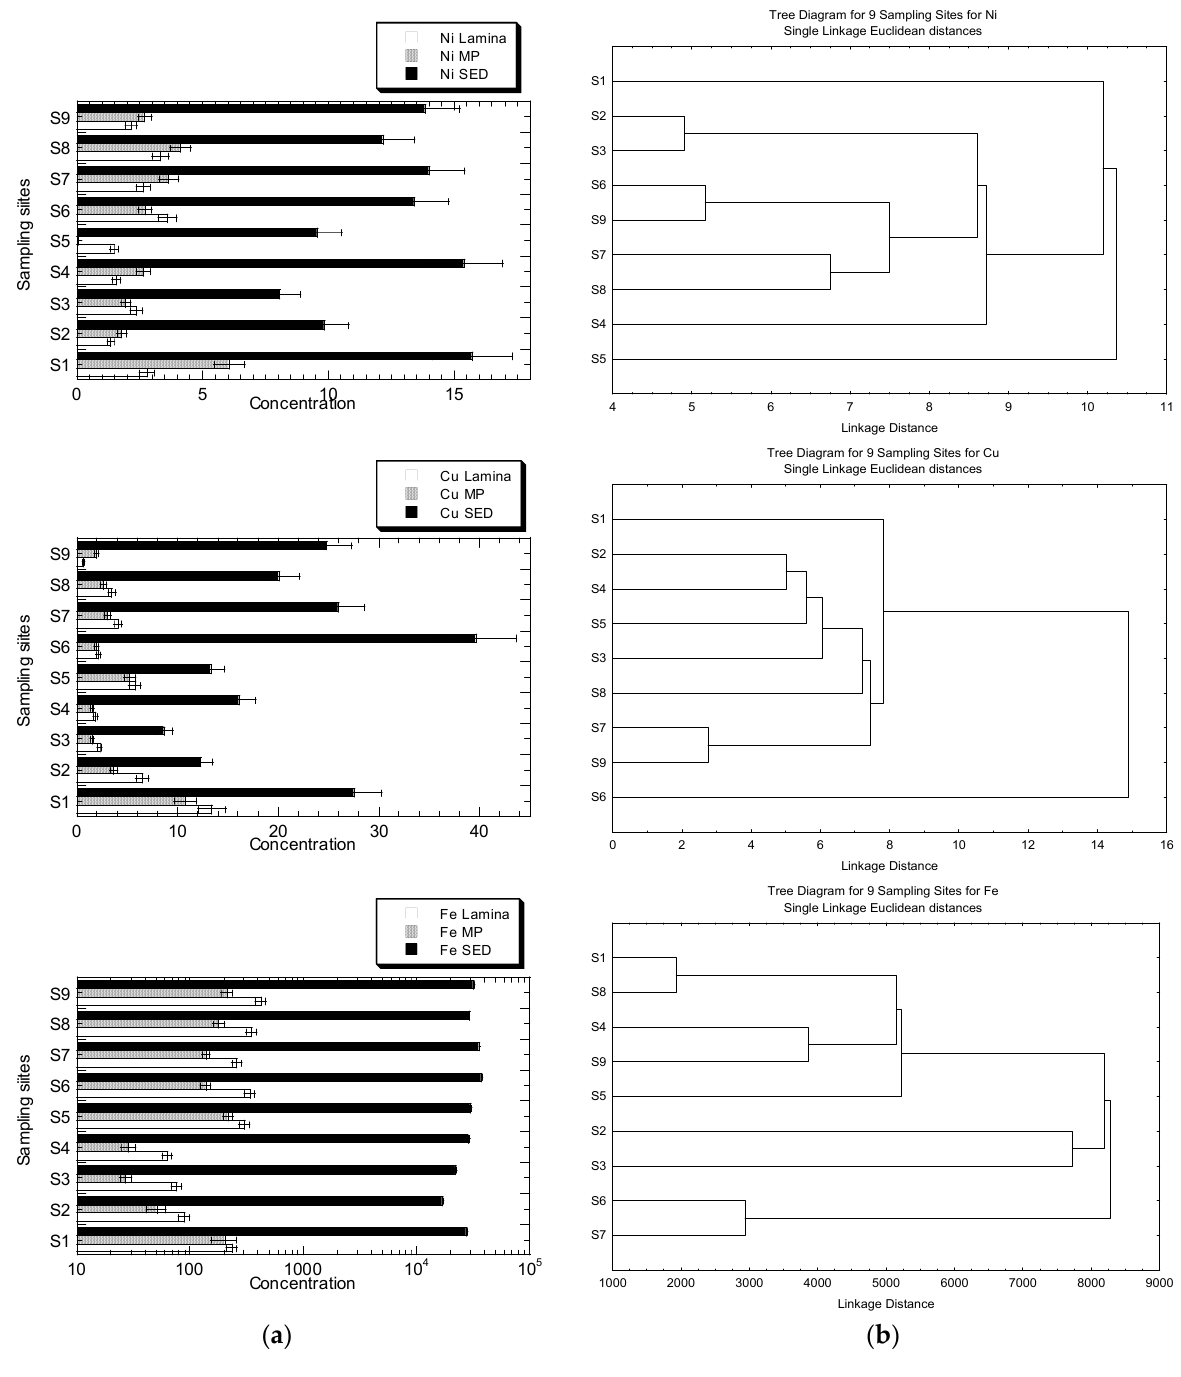
Figure 3. ( a ) Concentrations (mean ± standard error, mg/kg dry weight) of Cu, Fe, Ni, Pb, and Zn in the leave midrib plus petiole (MP), leaf lamina (Lamina) of Rhizophora apiculata , and their habitat surface sediments (SED = summation of four geochemical fractions) collected from Sepang River (S1–S4) and Lukut River (S5–S9). Note: Fe X-axis is drawn in logarithmic scale. ( b ) Clustering patterns of the nine sampling sites for Cu, Fe, Ni, Pb, and Zn, based on the metal concentrations in the leaves (lamina, and midrib plus petiole), and the geochemical fractions of the sediments (EFLE, AR, OO, RES, and SUM), as well as the values of BCF EFLE , BCF AR , BCF OO , BCF RES , and BCFS UM surface water parameters (temperature, conductivity, and salinity). Only the parameters with p < 0.05, based on the Shapiro–Wilk normality test, were log 10 (value + 1) transformed before cluster analysis; sampling sites’ information followed those in Table S1. The highest level of Zn in the sediment is found in S1, but it is not visibly found in the mangrove leaves. Overall, the levels of Zn and Ni in S1 and S4 are higher than in other sites, but the clustering patterns for both metals are not well indicated. The higher levels of Zn in S2 and S6 are also not visibly indicated in the clustering patterns. Only the highest